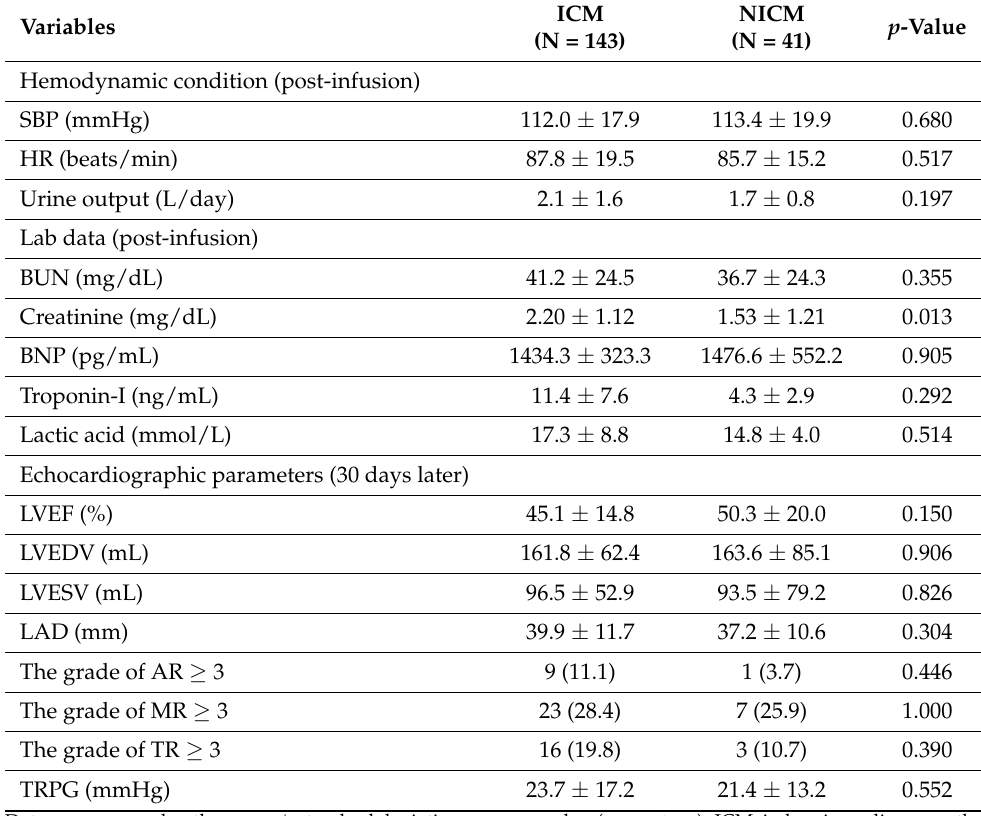
Table 2. Two-day later hemodynamic condition and follow-up echocardiographic